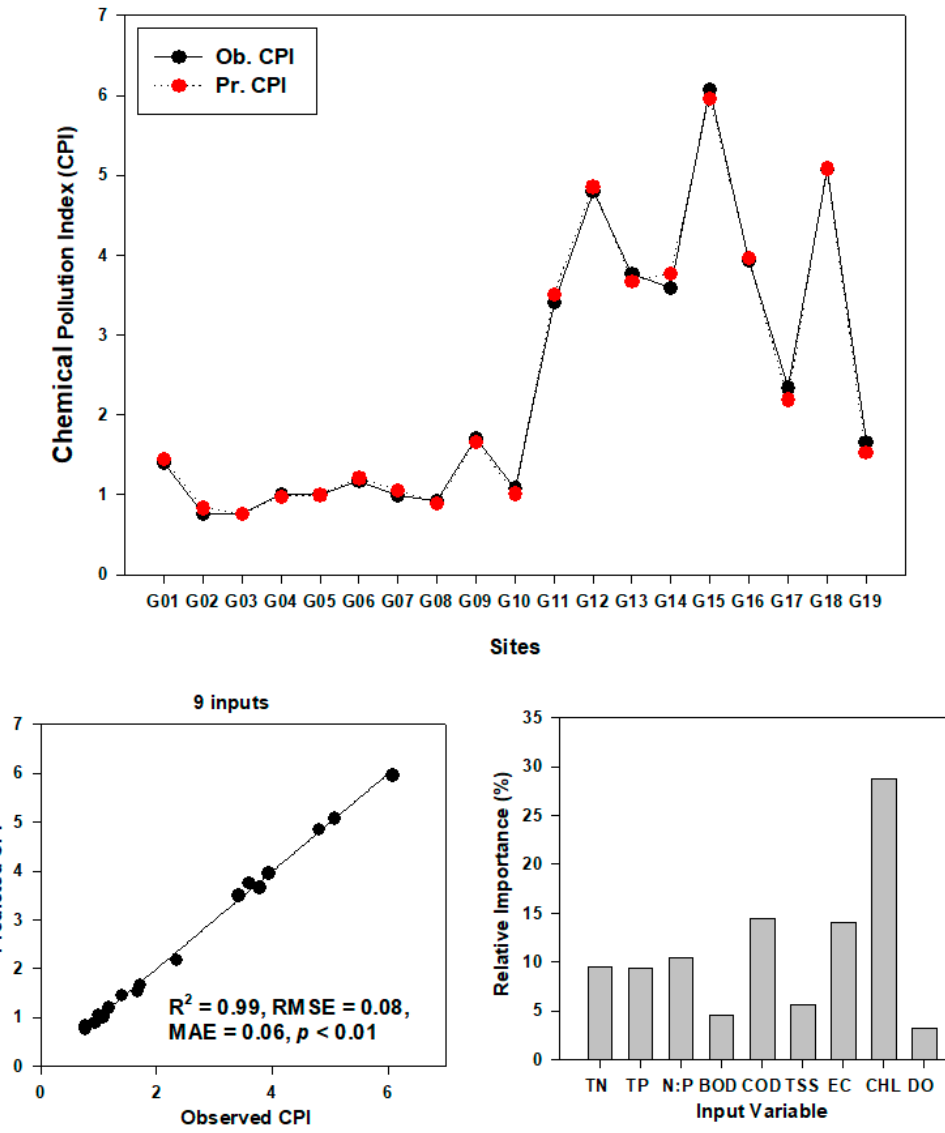
Figure 9. Prediction of the CPI model by artificial neural network model (TN—total nitrogen, TP—total phosphorus, N:P ratios, BOD—biological oxygen demand, COD—chemical oxygen demand, TSS—total suspended solids, EC—electrical conductivity, CHL—chlorophyll, and DO—dissolved oxygen).